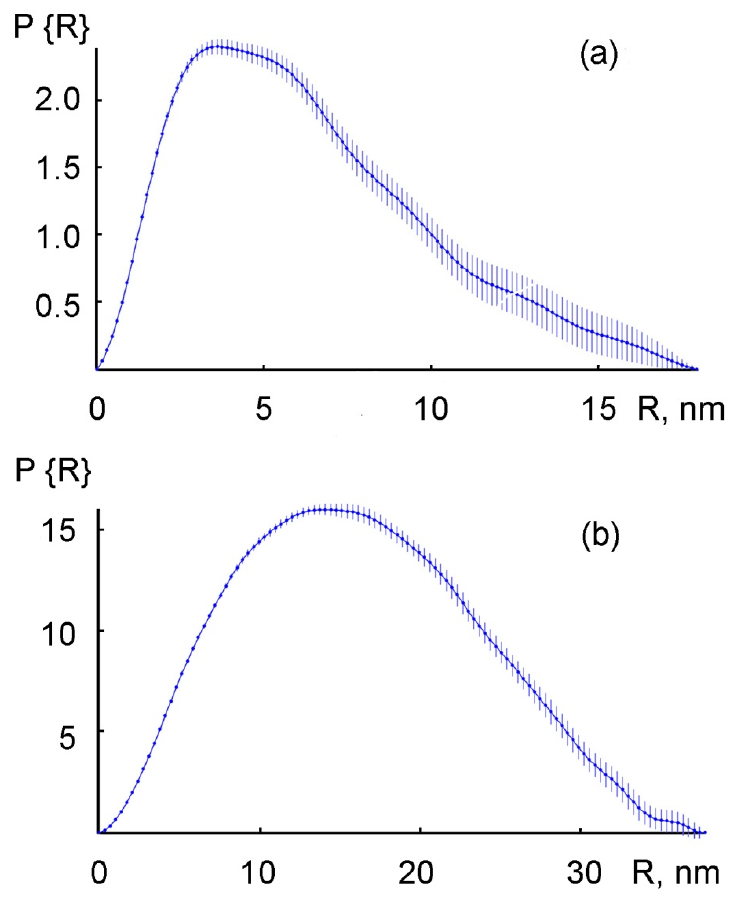
Figure 7. SAXS spectra of AuNPs size distribution for composites formed from electrolyte 3 ( a ) and electrolyte 4 ( b ).